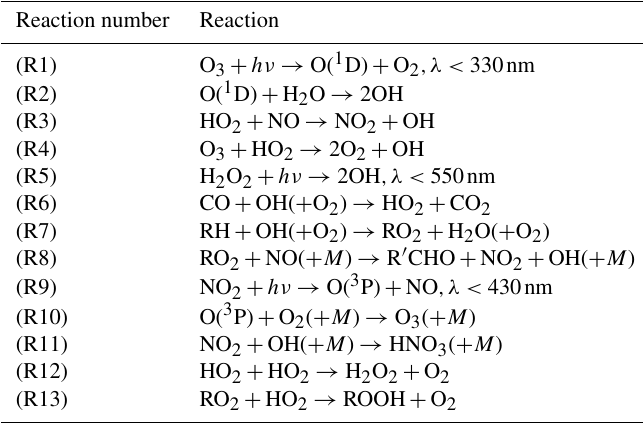
Table 1. Important reactions describing tropospheric OH